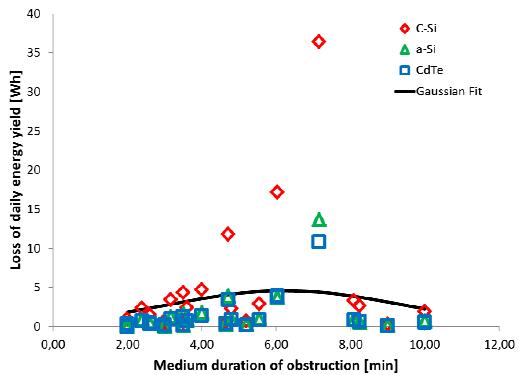
Figure 6. Loss of daily energy yield for the three modules types c- Si ( (cid:7) ), a-Si ( (cid:77) ) and CdTe ( (cid:3) ) as a function of the median duration of all the obstructions on a day with persistent contrails with on average 4.4 obstructions of the sun by contrails. The medium loss was estimated via a Gaussian fit, see solid line for the fit of the c-Si